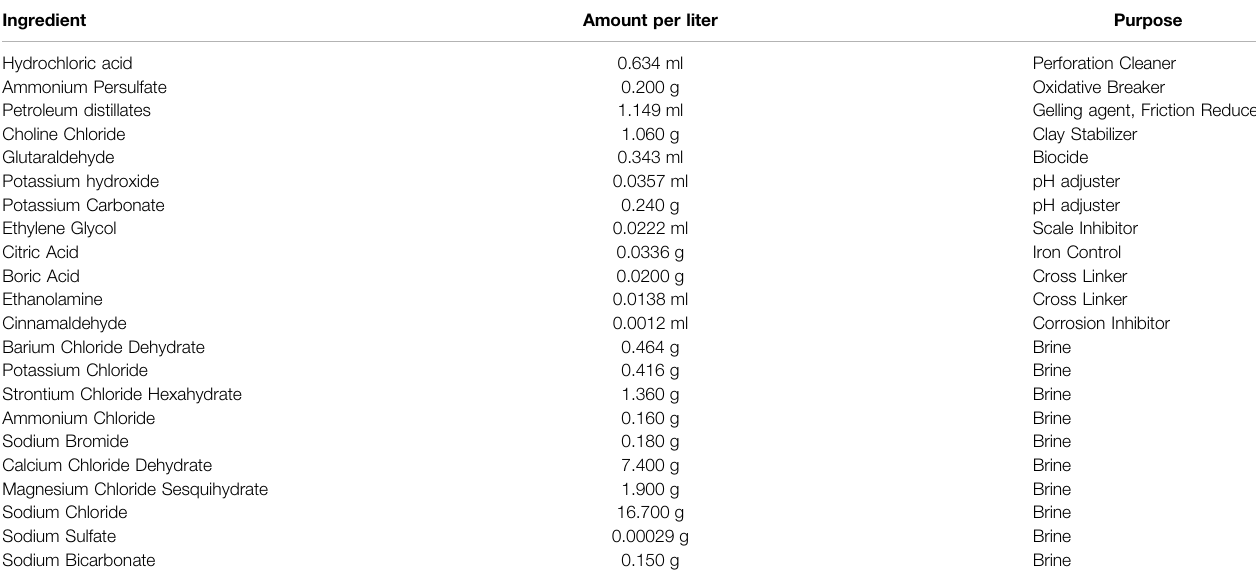
TABLE 2 | Fracturing fl uid additives and brine salts used to make the synthetic fracturing fl uid mixture used in reactions.